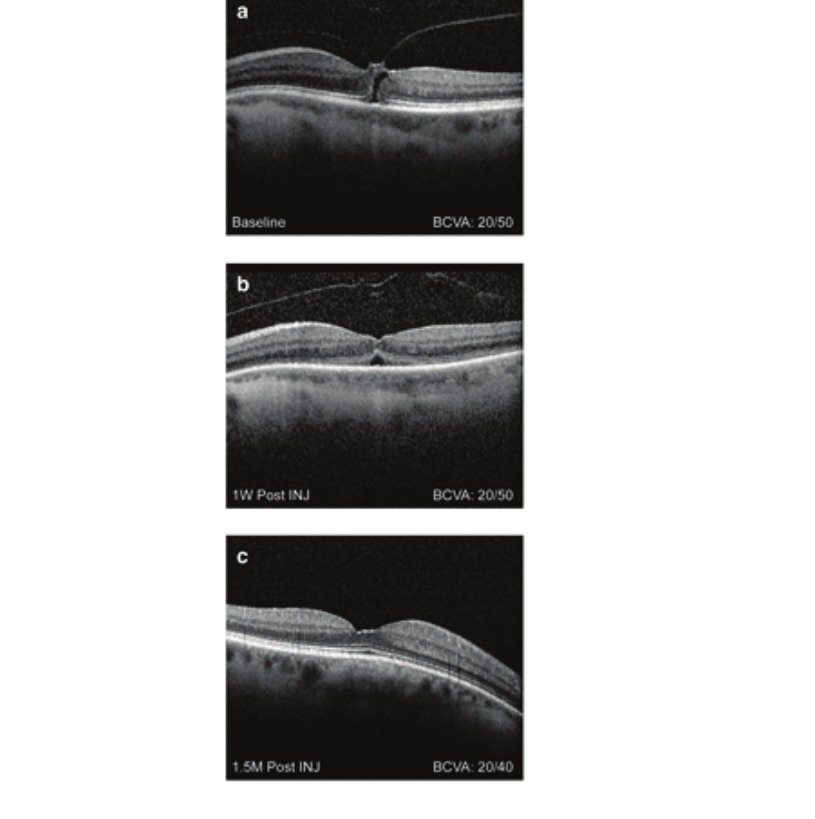
Figure 1. Case 1. Spectral domain optical coherence tomography of a 71-year-old female with VMA and a tractional macular hole in the left eye. (A) Baseline visit. No presence of ERM; BCVA 20/60. (B) One week post ocriplasmin injection. VMA resolved and macular hole closed, but increased presence of SRF; BCVA 20/50. (C). Seven weeks post treatment. Macular hole remains closed, no evidence of SRF; BCVA 20/40. BCVA, best-corrected visual acuity; ERM, epiretinal membrane; INJ, injection; M, month; SRF, subretinal fluid; W,